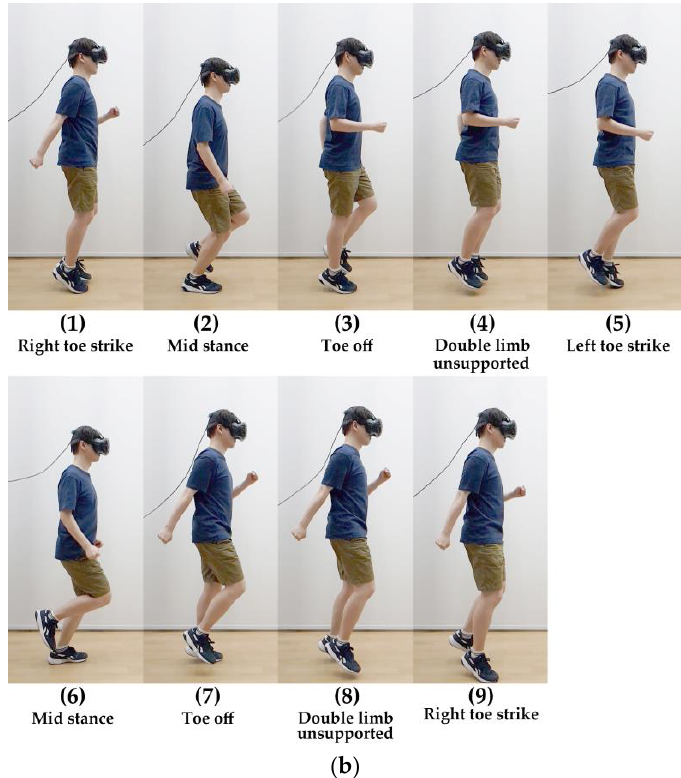
Figure 6. Correlation of 𝑌 𝑝𝑜𝑠 and H with the motion when jog-in-place is performed. ( a ) 3 to 6 represent the step recognition cycle of our method. This cycle corresponds to both feet. ( b ) The jog-in-place cycle repeats the order of right toe strike – mid stance (midfoot strike) – toe off – double limb unsupported (maximum HMD height) – left toe strike – mid stance (midfoot strike) – toe off – double limb unsupported (maximum HMD height) – right toe strike.